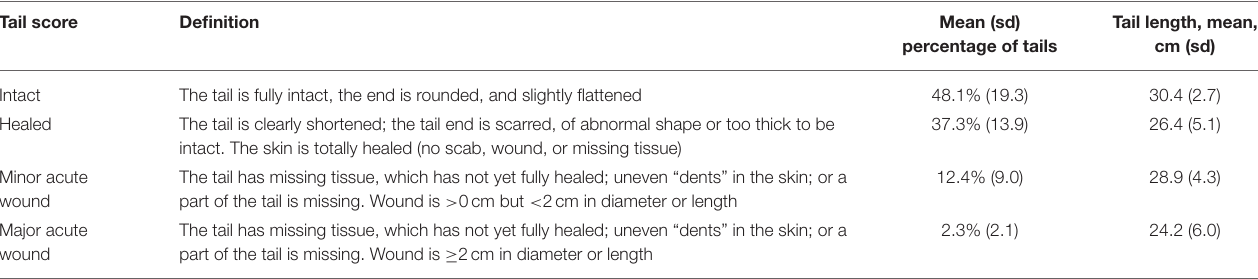
TABLE 1 | Tail scoring system used at the slaughter line after scalding of the carcass and the mean percentage and standard deviation of one delivery group of finishing pigs from 84 herds (10,517 carcasses) according to their tail lesion scores and tail length in centimeters. Tail